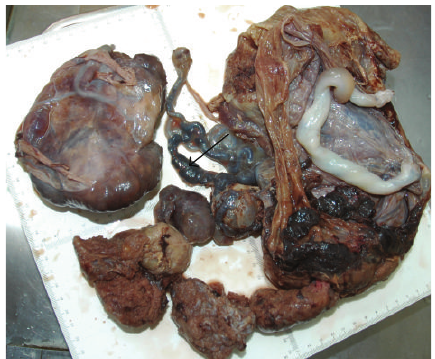
Figure 4: Photograph of the gross specimen of the placenta; the placenta measured 30 × 25 × 4.5 cm and weighed 1370 g, and the largest tumor measured 11 × 8 × 4.5 cm. Arrow pointing to the fetal plate showed enlarged varicose chorionic